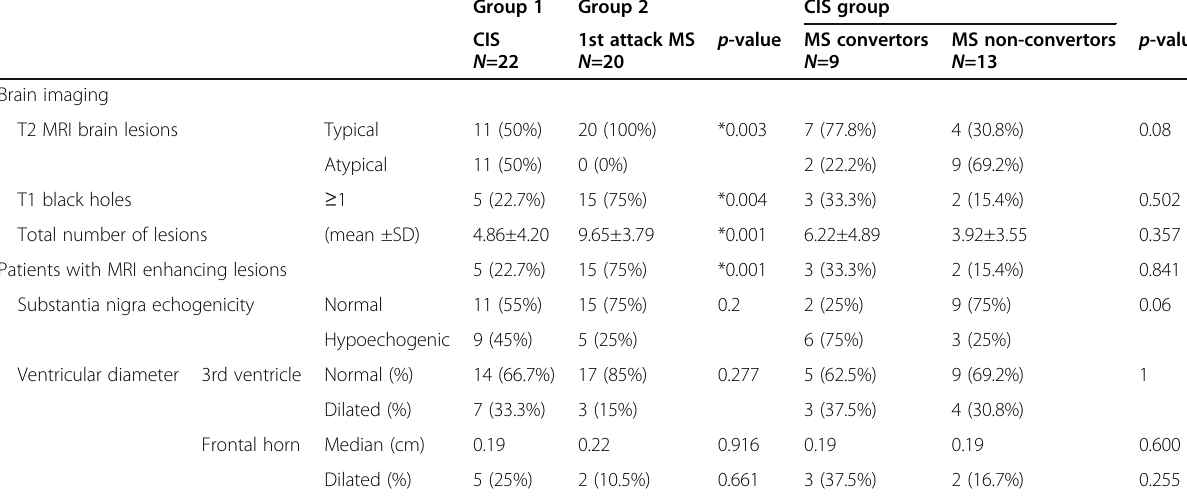
Table 3 Ultrasonography assessment and MRI results of all studied groups